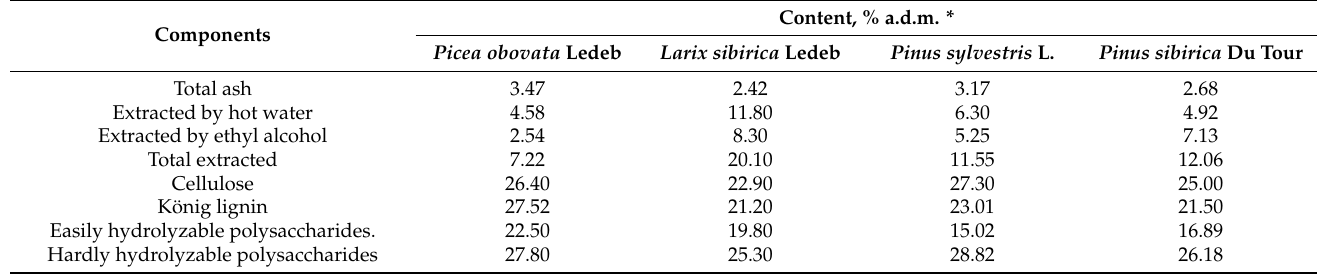
Table 1 provides the chemical composition of softwood bark [49–53]. Table 1. Siberian softwood bark chemical composition